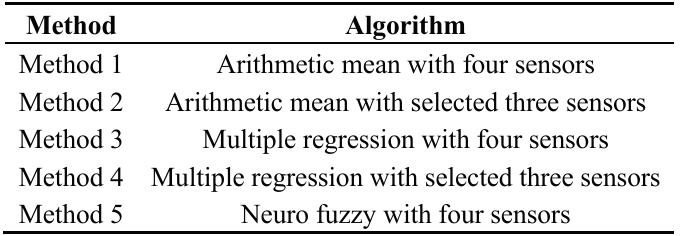
Table 3. Tested algorithms for sludge density